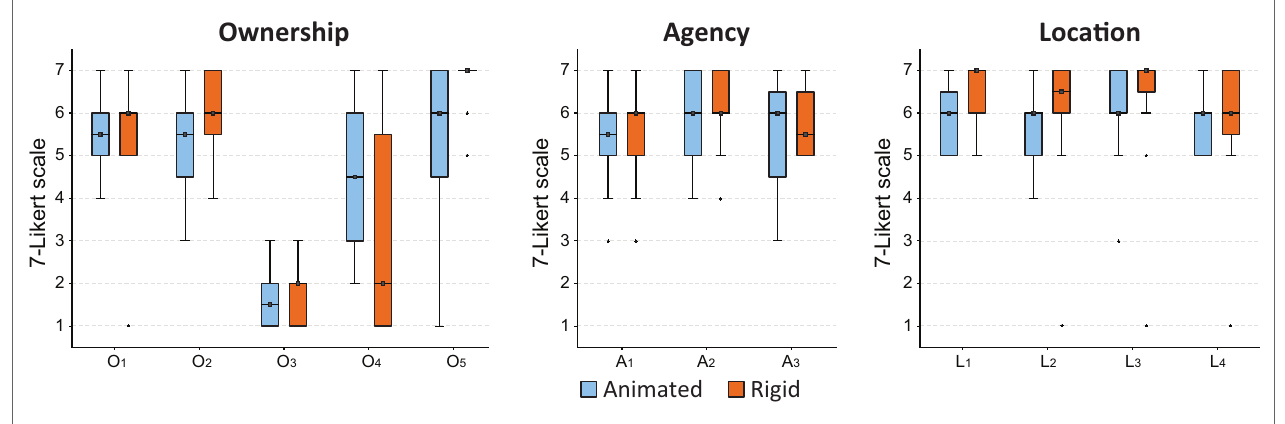
FigUre 6 | Ownership, agency, and location ratings for the final questionnaire . TaBle 3 | statistical summary of the questionnaire responses (7-likert scale), including mean and se.